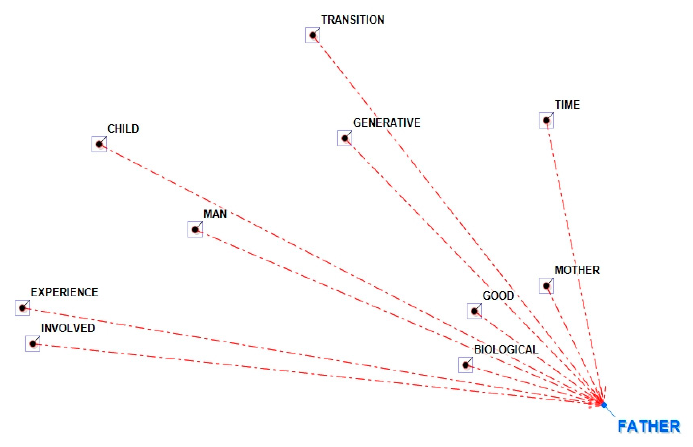
Figure 13. Predecessors of “father”.